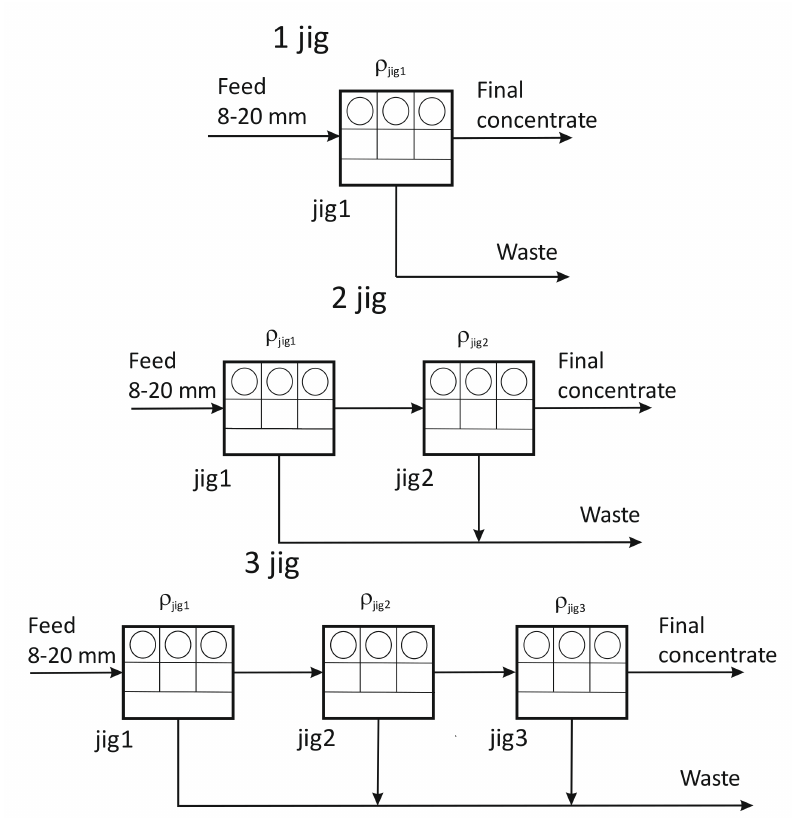
Figure 8. Systems of one, two and three separators with secondary enrichment of intermediate